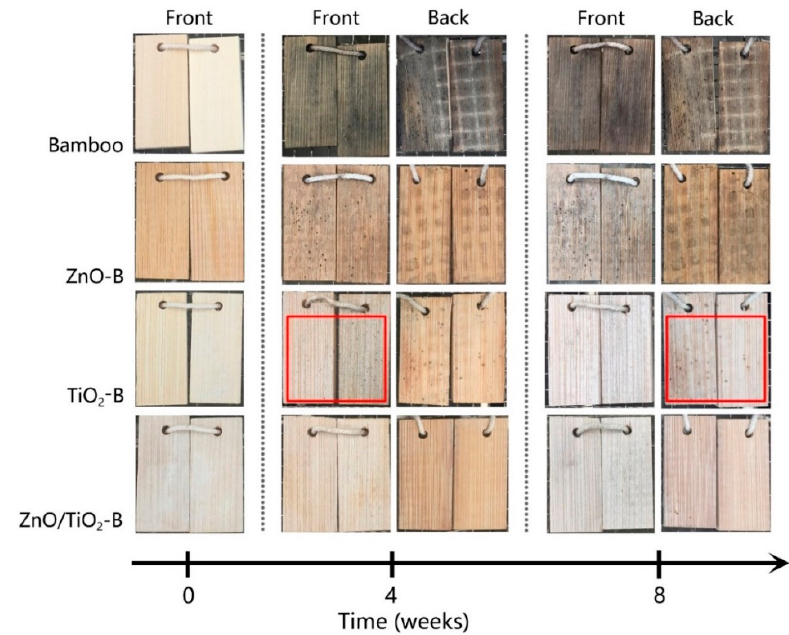
Figure 5. Digital photograph (front and back) of pristine bamboo, ZnO-B, TiO 2 -B and ZnO/TiO 2 -B after four weeks of exposure and eight weeks of exposure, respectively.